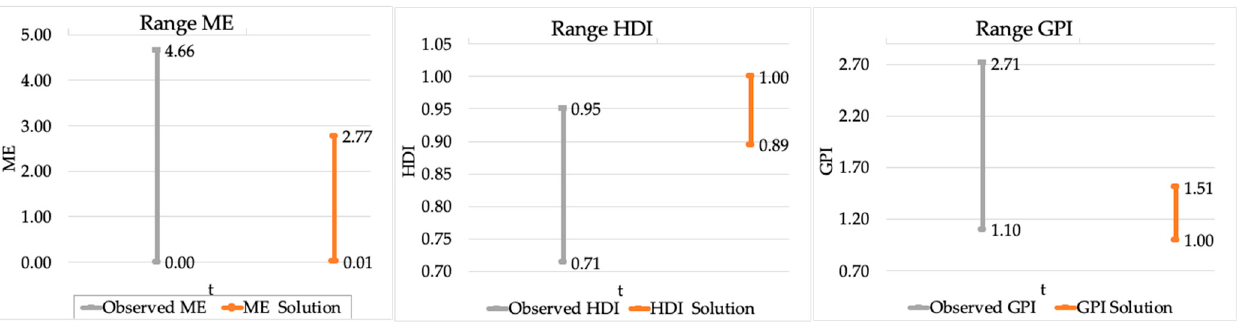
Figure 3. Comparison of objective function variation ranges between the modeled ε - Pareto front and observed values from the dataset.